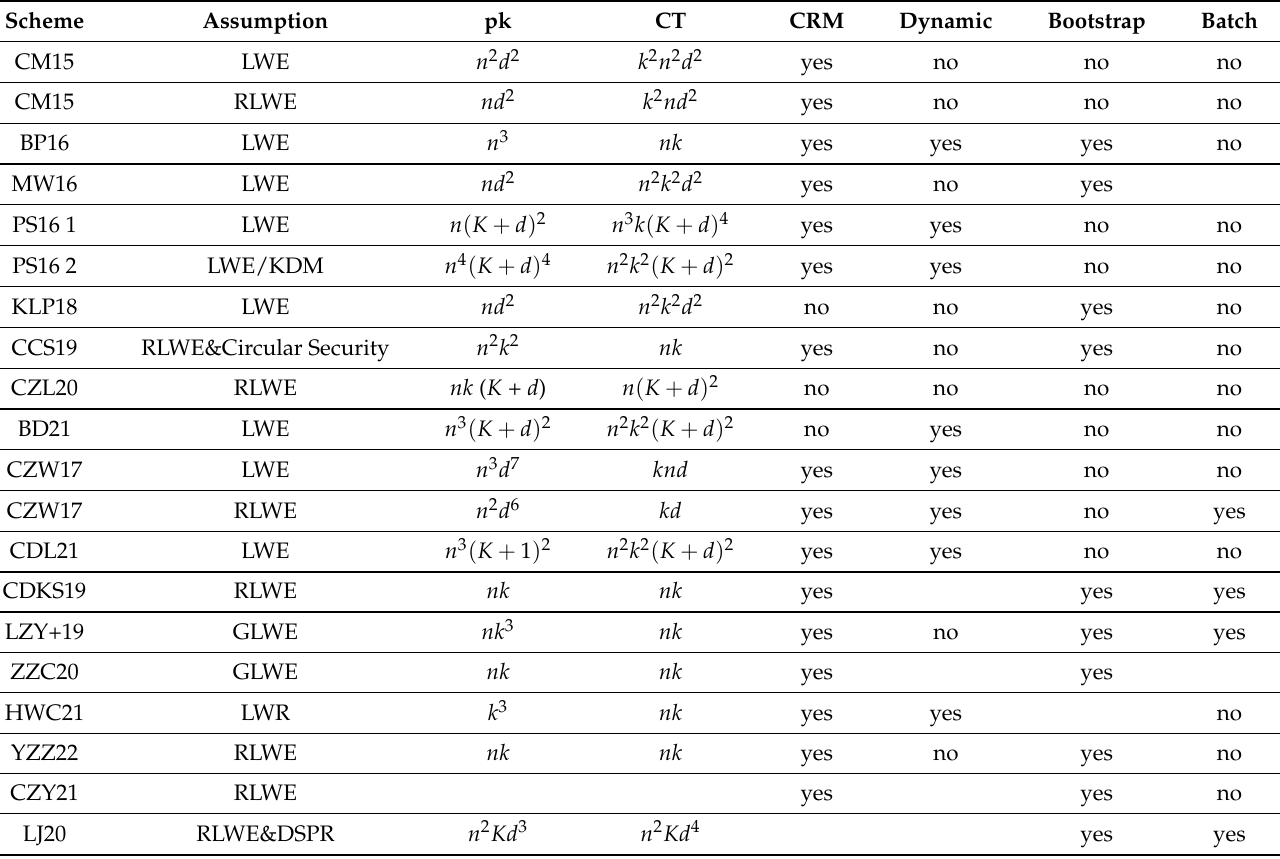
Table 5. Comparison of selected